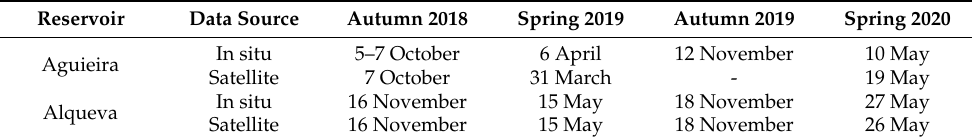
Table 1. Match-ups between sampling dates and satellite imagery